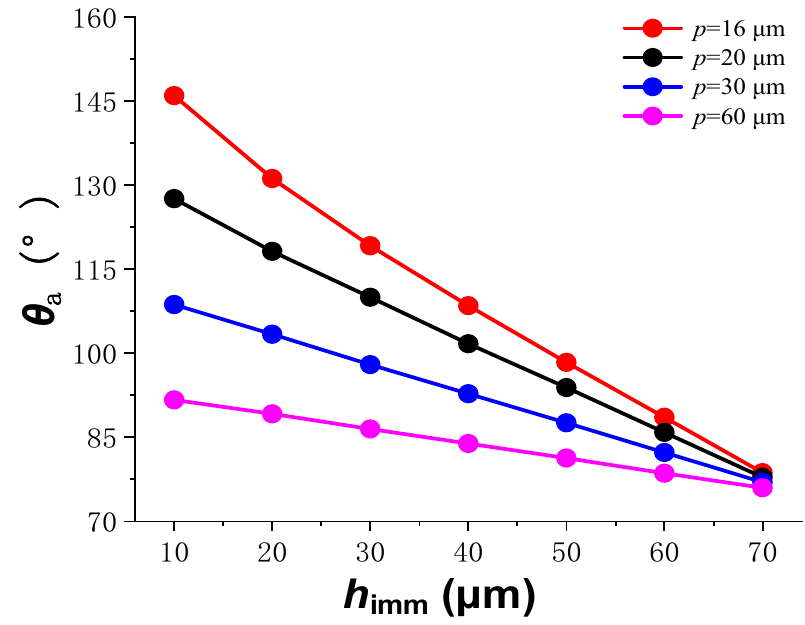
Figure 6. Variation range of apparent contact angle under different microstructure spacings.